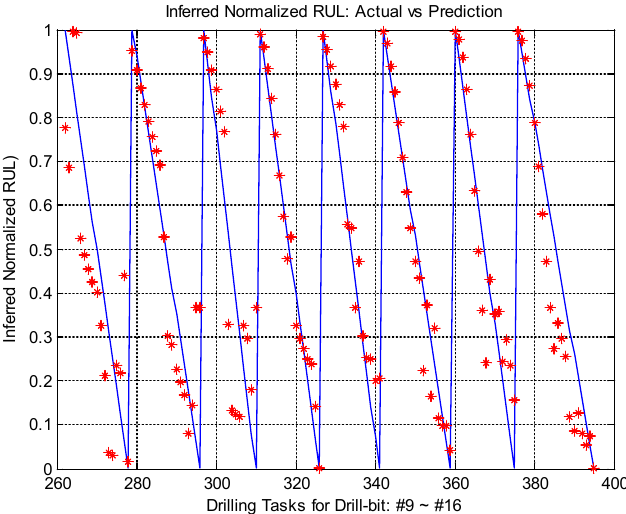
Figure 9. Normalized inferred RUL (blue line) vs. predicted RUL (red dotted line) for drill-bits #5~#8 in a delayed online setup.